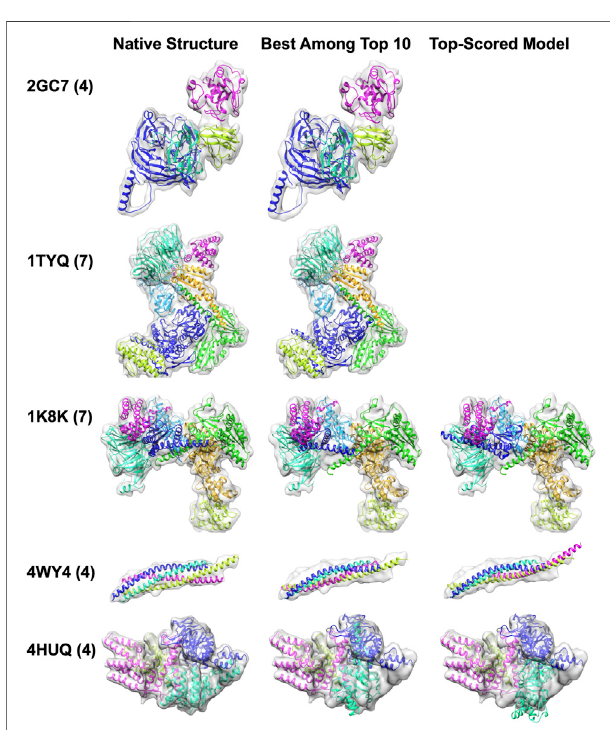
FIGURE 4 | Structure fi tting examples of simulated map targets. The number of chains in a complex is shown in the parentheses. The middle panel shows the best among the top 10-scored models, and the right panel shows the top-scored models. Only one fi tted structure was shown for 2GC7 and 1TYQ because the top-scored model was the best among the top 10-scored models. 2GCN, the human RhoC-GDP complex. 1TYQ, Arp2/ 3 complex withbound ATPor ADP. 1K8K, bovine Arp2/3 complex. 4WY4, an autophagic SNARE complex. 4HUQ, folate ECF transporter from Lactobacillus brevis